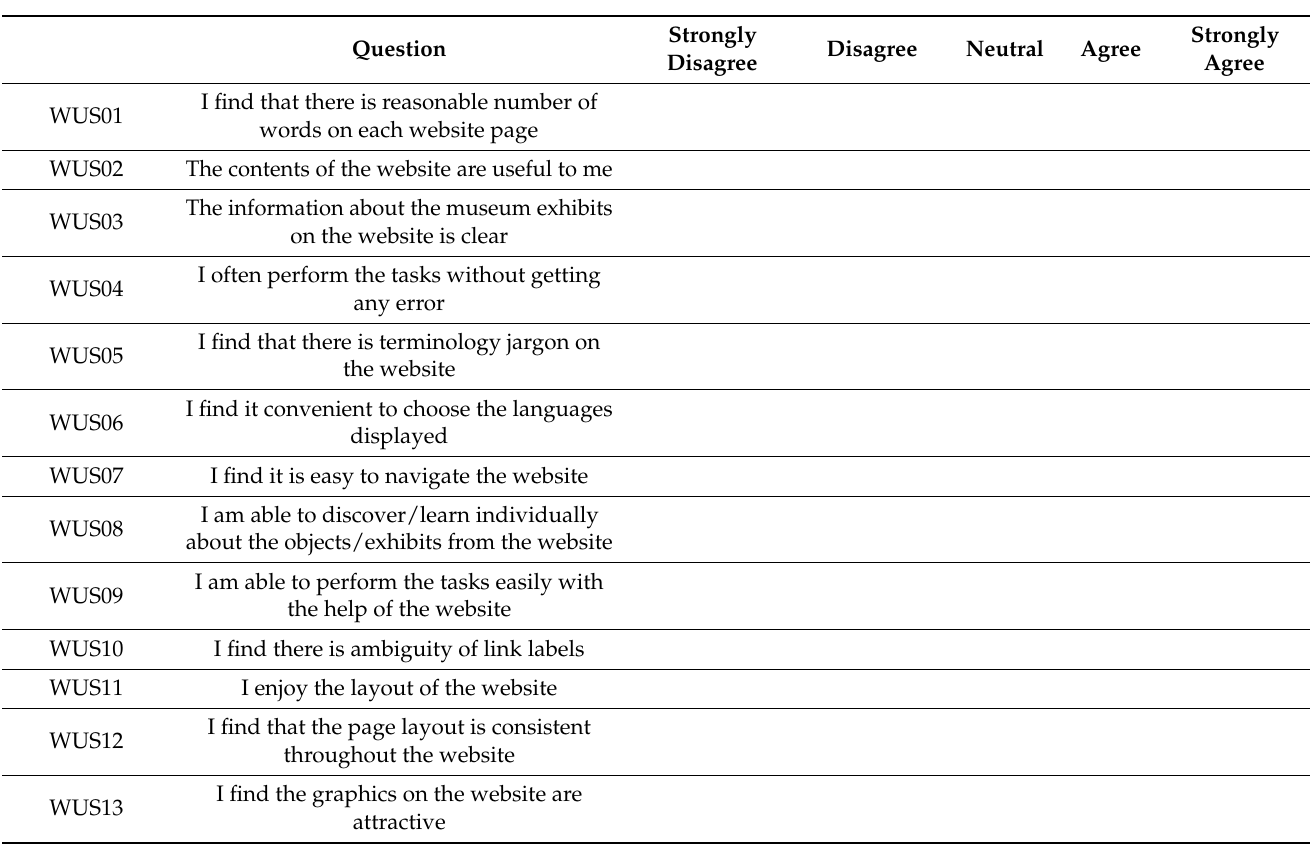
Table A3. Questionnaires for Website (English